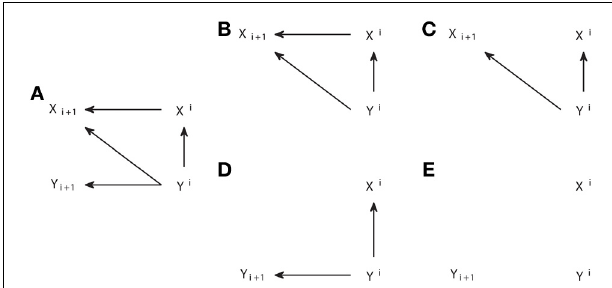
FIGURE 6 | Graphical procedure to apply d-separation to check the conditional independencies associated with Granger causality. (A) Causal structure corresponding to a system with unidirectional causal connections from process Y to X . (B,C) Steps 1 and 2 of modification of the